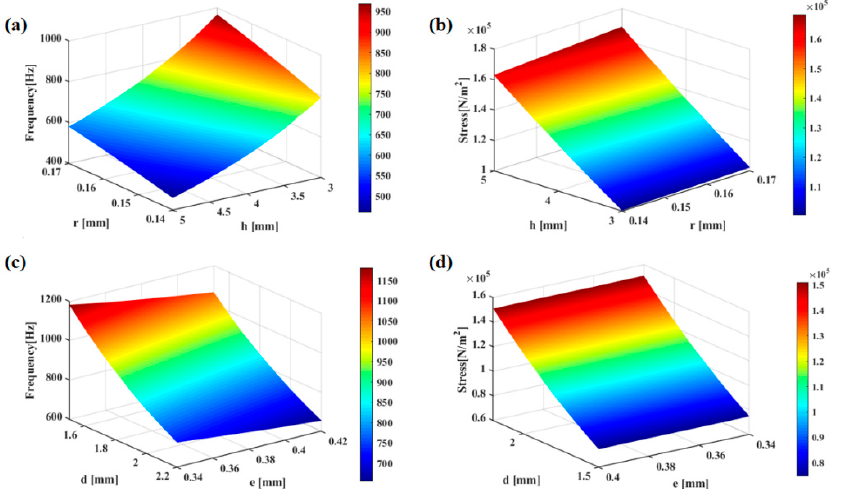
Figure 10. ( a ) Effects of radius r and height h on the natural frequency. ( b ) Effects of height r and radius h on the maximum beam stress. ( c ) Effects of the concave diameter d and the concave cilium width e on the natural frequency. ( d ) Effects of concave diameter d and concave cilium width e on the maximum stress on the beam.